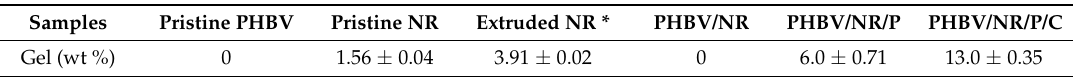
Table 3. Gel fractions of pristine PHBV, pristine NR, and PHBV/NR blends determined by chloroform extraction.